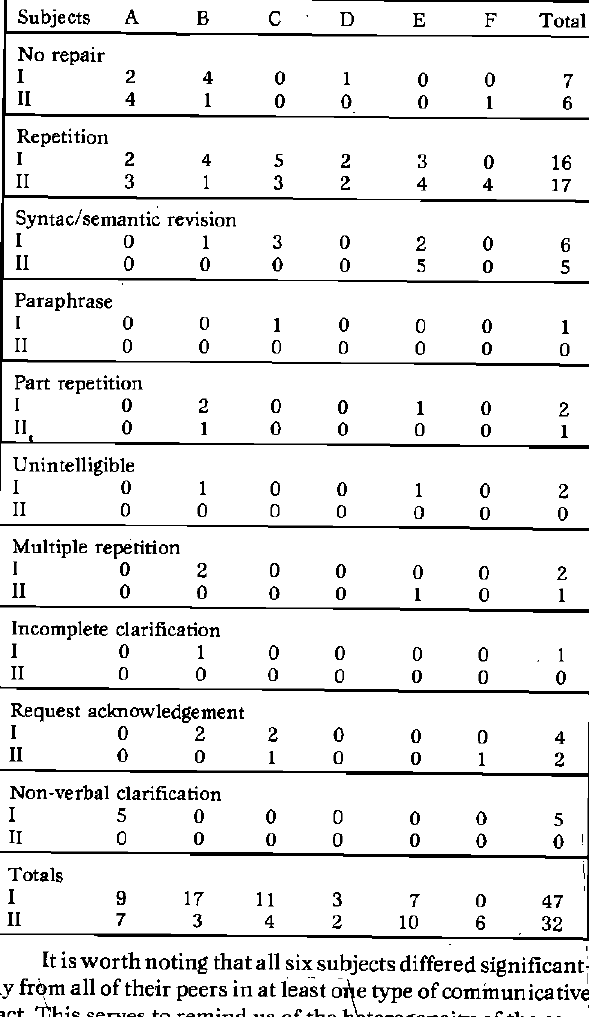
Table 8: Responses to Clarification Requests for all sub- jects in Interactions I and